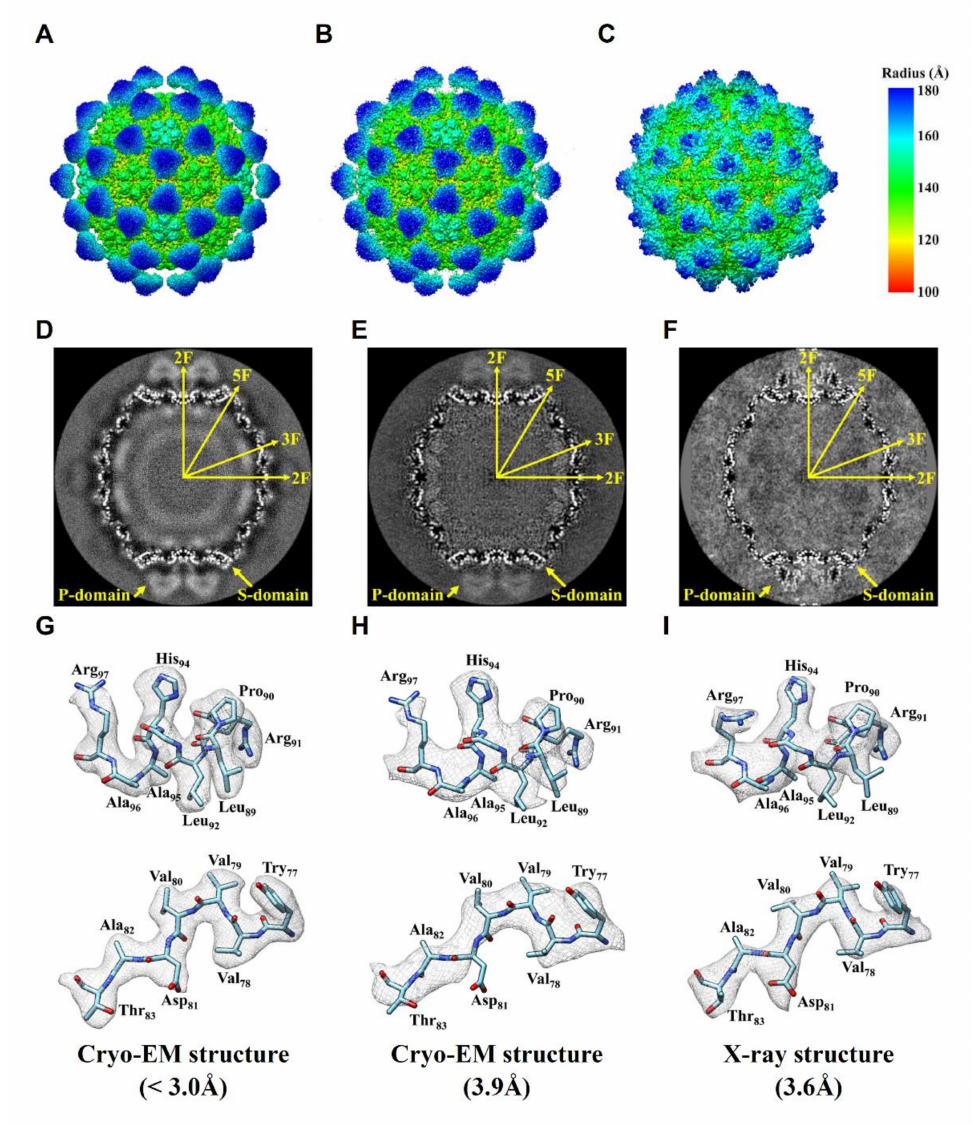
Figure 3. Comparison of the NNV structures. ( A – C ) From left to right are our DGNNV cryo- EM structure (from setting B), earlier OSGNNV cryo-EM structure, prepared from EMDB-6453 and PDB:3JBM, and RGNNV X-ray structure, prepared from PDB:4WIZ), respectively. The color spectrum indicates the distance from the center. ( D – F ) The corresponding views of central sections. ( G – I ) Representative α -helix and β -sheet. The density map is represented in gray mesh. The atoms of oxygen, nitrogen and carbon are colored as red, blue and cyan,